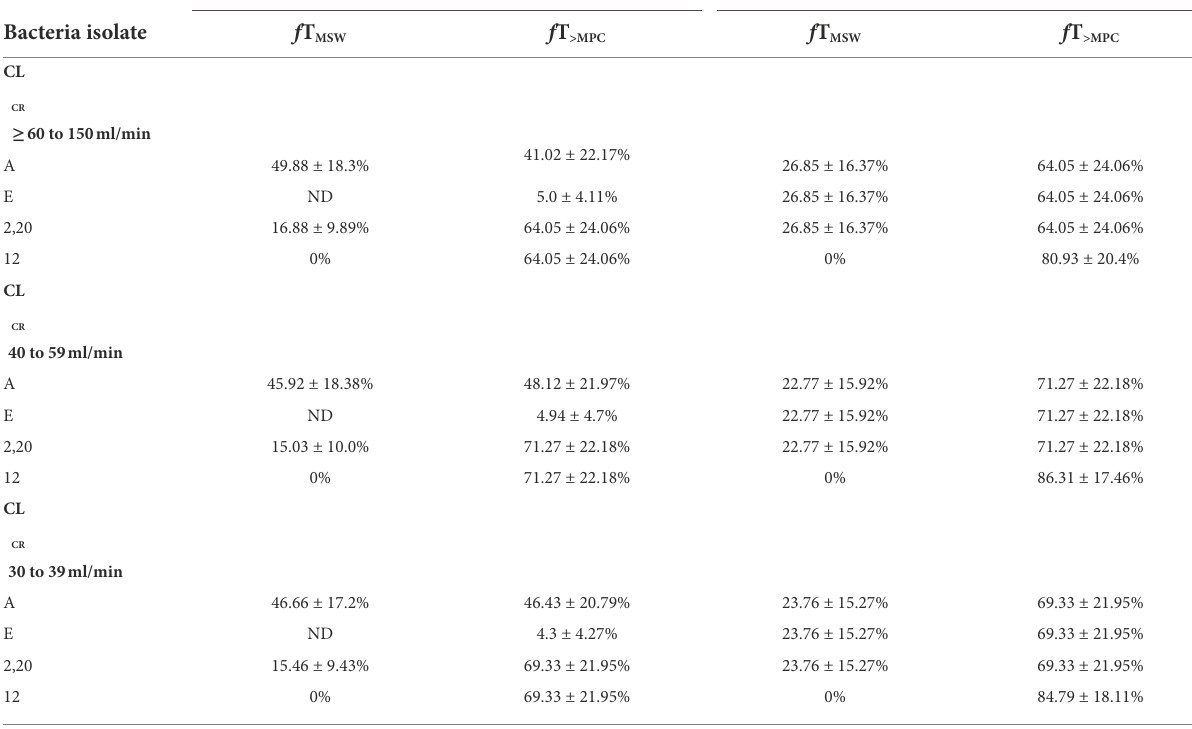
TABLE 4 Pharmacodynamic parameters f T MSW and f T >MPC based on MIC and MPC of amikacin ‡ in plasma against five Acinetobacter baumannii isolates harboring OXA-23 and other serine- β -lactamases. Double-combination of amikacin with polymyxin-B